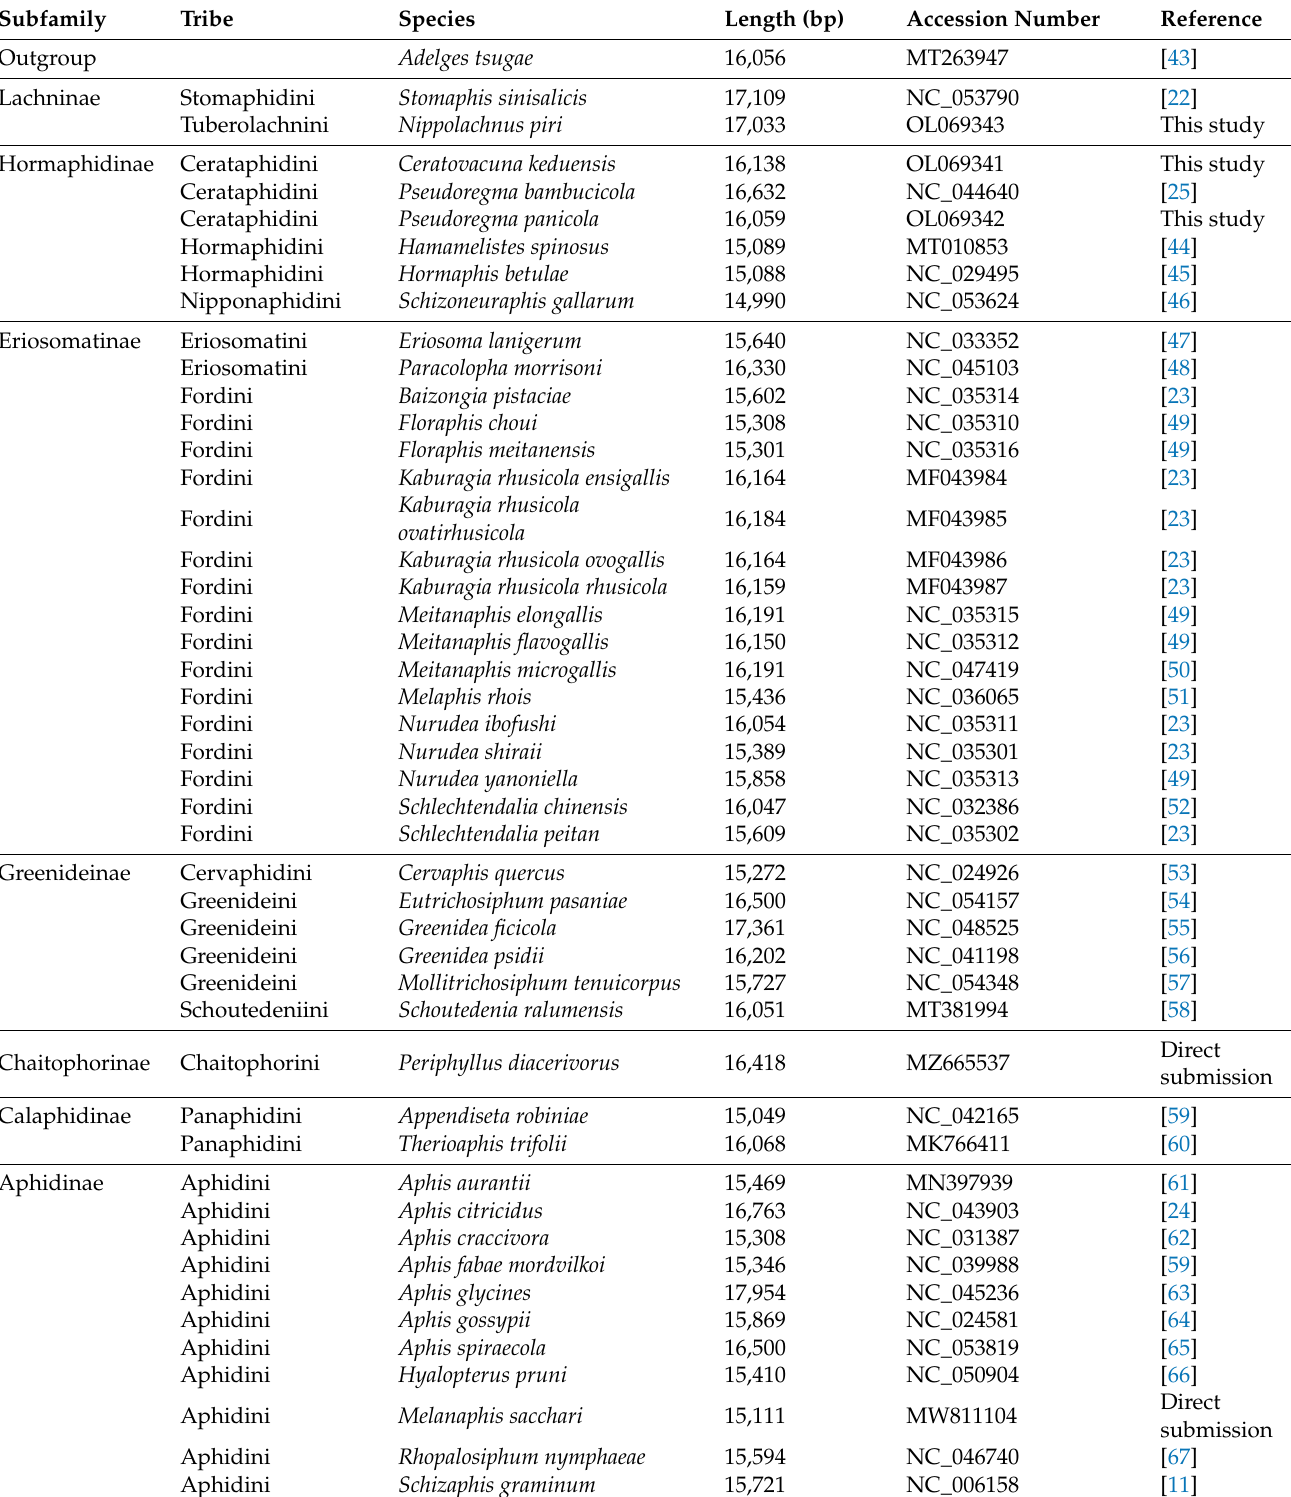
Table 1. Information of complete aphid mitogenomes used in this